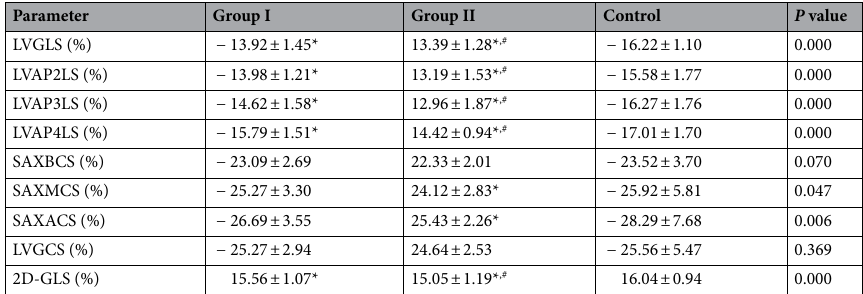
Table 3. Strain analysis. Data are presented as mean ± standard deviation. LVGLS, left ventricular global longitudinal strain; LVAP2LS, longitudinal strain of the left ventricle in apical two-chamber view; LVAP3LS, longitudinal strain of the left ventricle in apical three-chamber view; LVAP4LS, longitudinal strain of the left ventricle in apical four-chamber view; SAXBCS, circumferential strain measured at the basal left ventricular level; SAXMCS, circumferential strain measured at the mid left ventricular level; SAXACS, circumferential strain measured at the apical left ventricular level; LVGCS, left ventricular global circumferential strain; 2D-GLS, two dimensional global longitudinal strain. *Compared with control group, P < 0.05. # Compared with group I, P < 0.05.